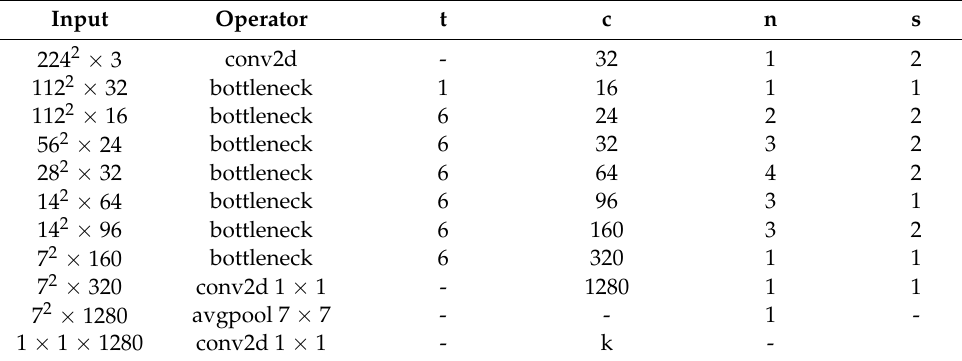
Figure 6. Structure of the MobileNetV2 network. Table 2. Parameters of the MobileNetV2 network.